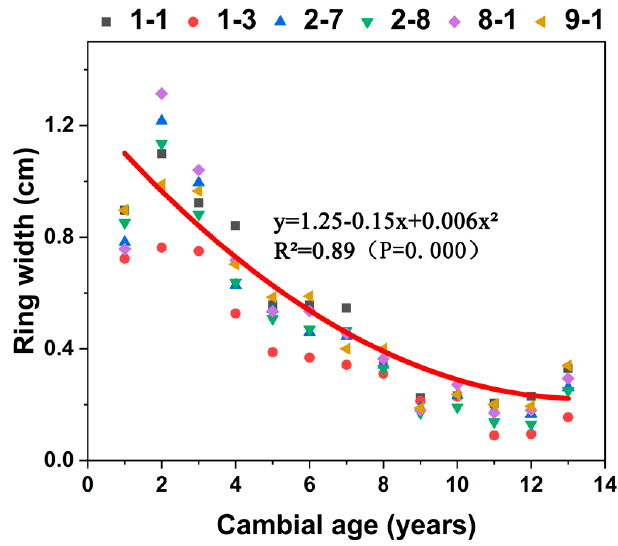
Figure 4. Average ring width of wood in six C. bungei clones versus cambial age.